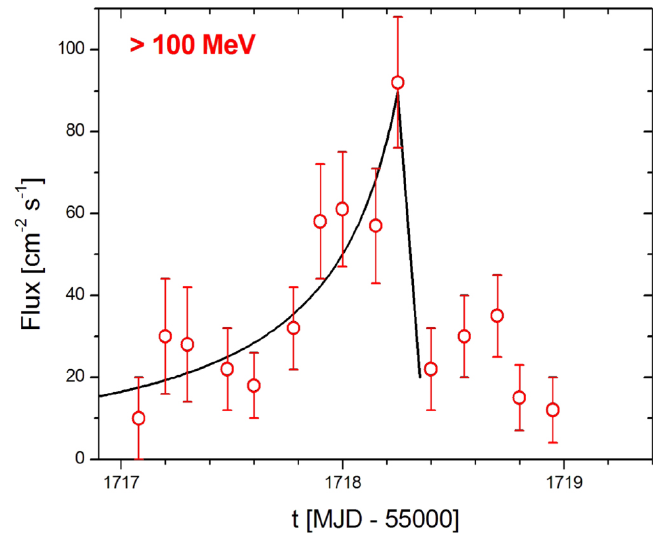
Figure 14. Simulated γ -ray light curve in a leptonic synchrotron mirror model. From [123]. Reproduced with permission from the American Astronomical Society